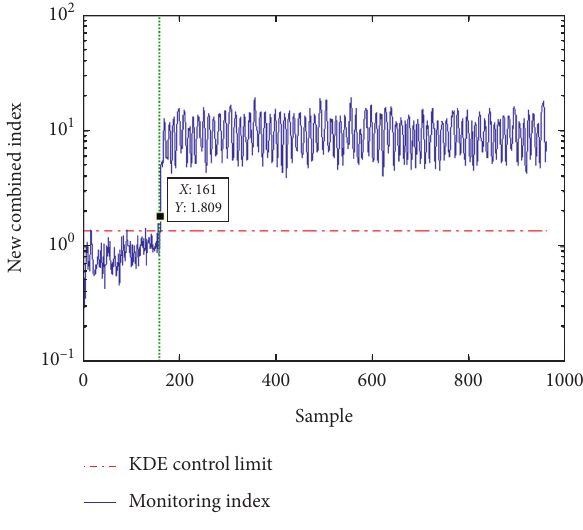
Figure 4: Monitoring index for fault 14.